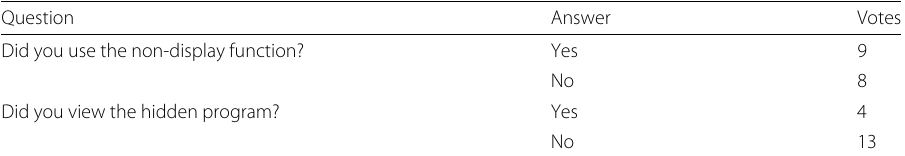
Table 3 Questions on the non-display function Question Answer